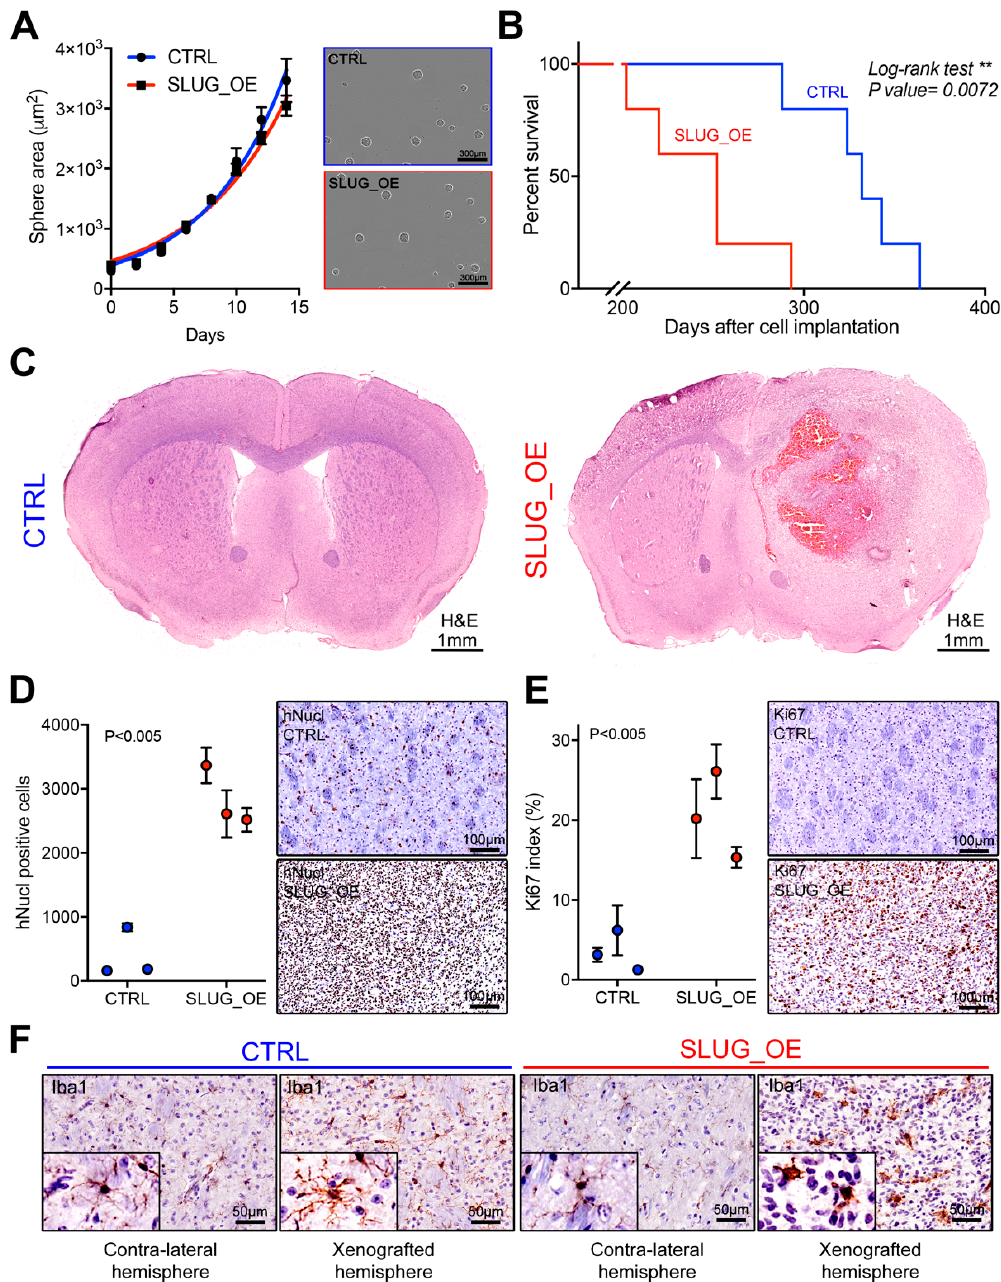
Figure 5. SLUG overexpression promotes a more proliferative, inflammatory, and aggressive phenotype in vivo (see also Figure S6). ( A ) Graphical representation of BT69 CTRL and SLUG_OE sphere size over time and representative images at day 10. ( B ) Kaplan–Meier curves of mice xenografted with BT69 CTRL and SLUG_OE cells. ( C ) Representative H&E sections of BT69 CTRL and SLUG_OE tumors. Quantitative analysis of ( D ) hNucl positive cells, ( E ) Ki67 index in CTRL and SLUG_OE tumors and representative images. ( F ) Representative images with 2.5x close-up inserts of Iba1 staining in the xenografted and contra-lateral hemispheres of mice xenografted with CTRL and SLUG_OE cells. Error bars represent SD ( A , D , E